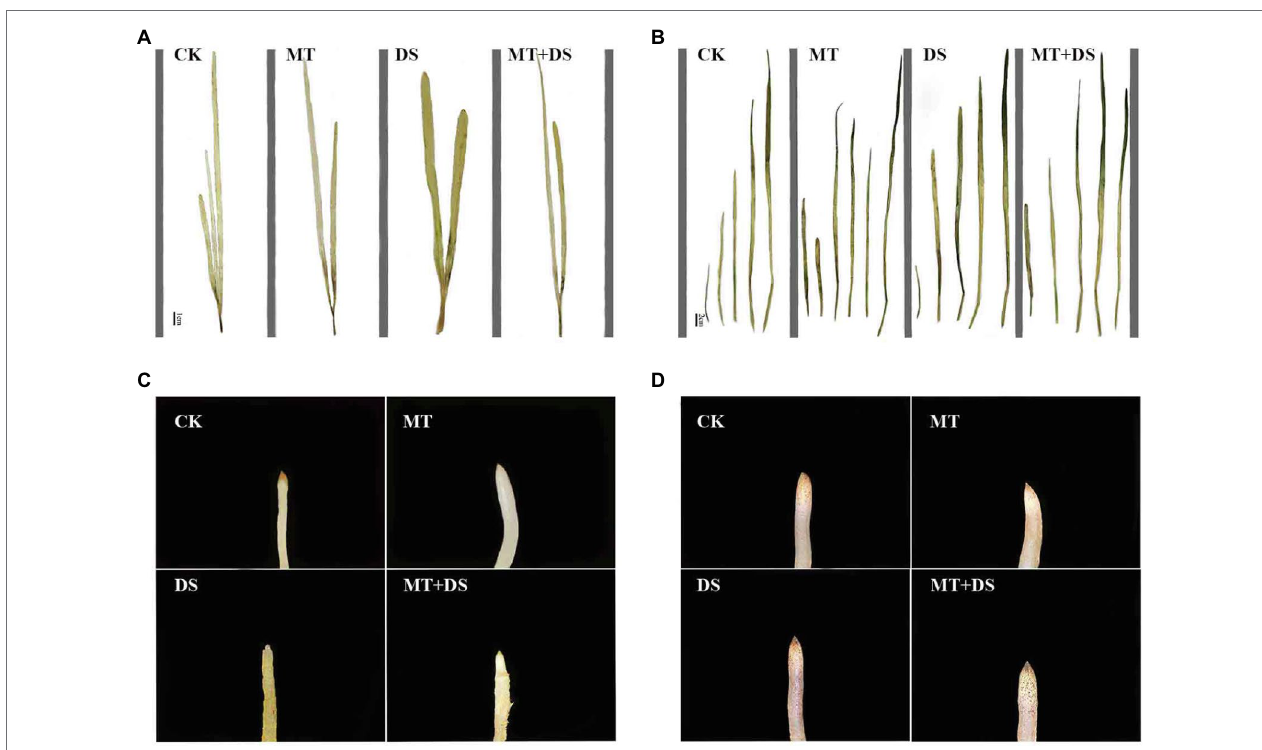
FIGURE 14 | DAB histochemical detection of H 2 O 2 in triticale plant parts. (A) Leaf staining on 10 th day, (B) leaf staining on 20 th day, (C) root staining on 10 th day and (D) root staining on 20 th day. To visualize the DAB deposits, leaves were decolorized in boiling ethanol and the brown sediments of H 2 O 2 in the spots were